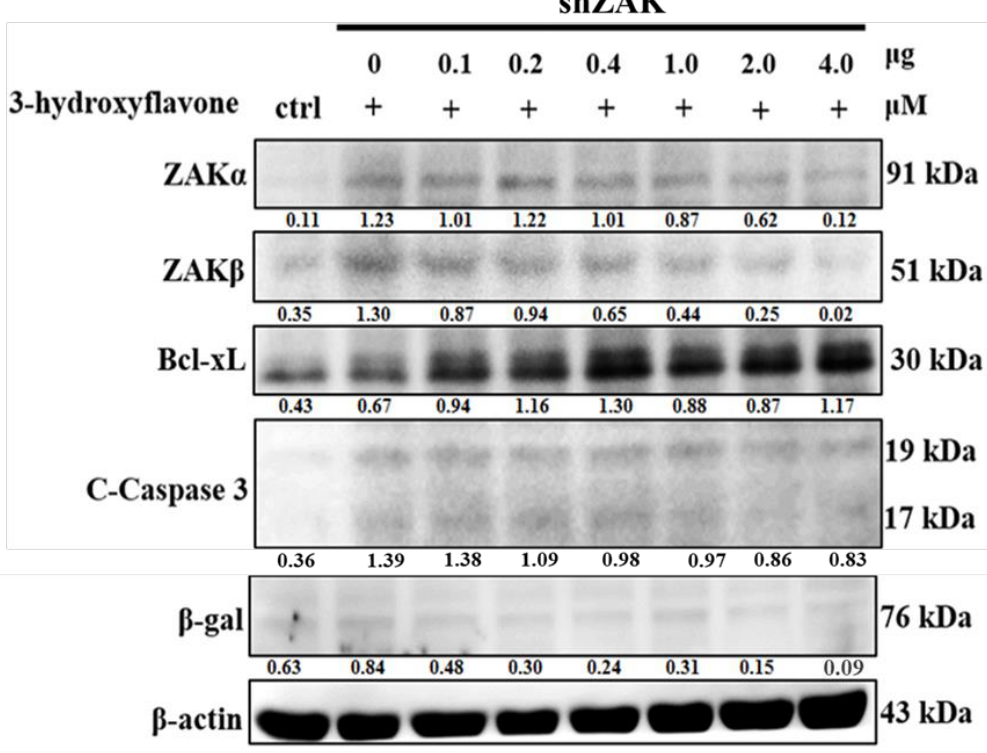
Figure 3. Role of ZAK in 3-HF-induced apoptosis in HOS cells. Western blot analysis of the expression of ZAK, apoptotic protein C-Caspase 3, survival protein Bcl-xL and β -gal by transient transfection of shZAK in a dose-dependent manner (0.1–4.0 µ g / mL) following 3-HF treatment (20 µM).